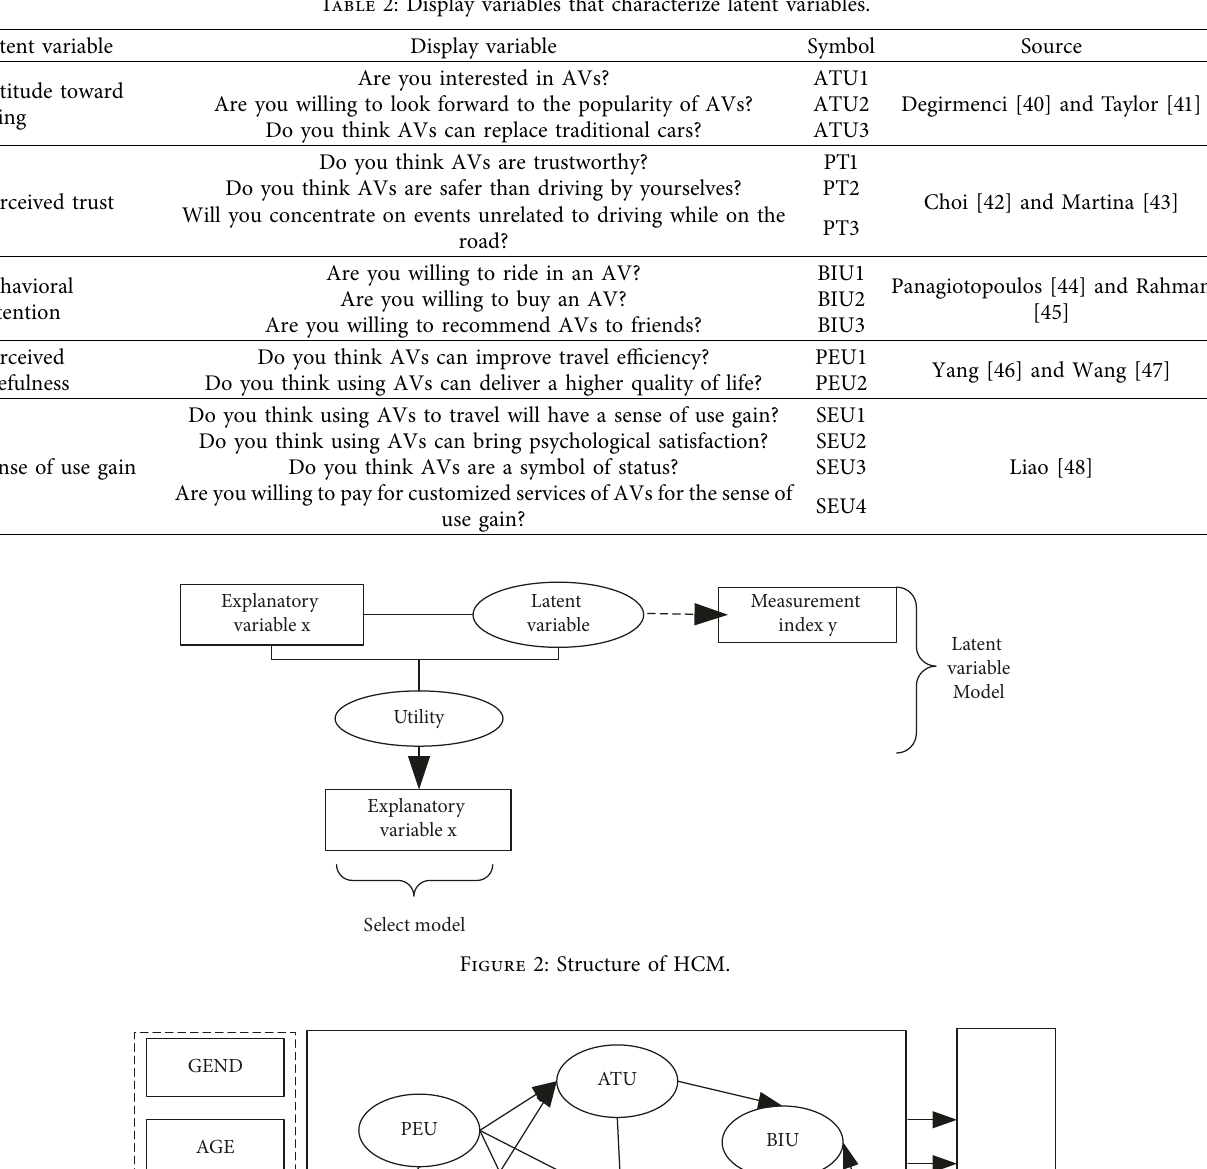
Table 2: Display variables that characterize latent variables.